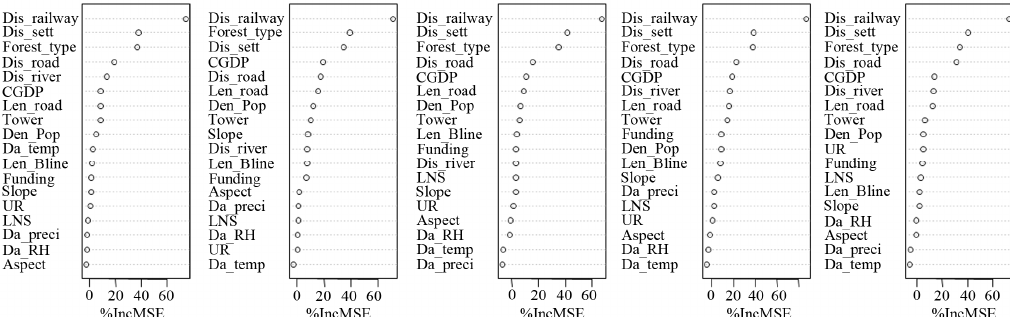
Figure 4. Variable importance measures from Random Forest sub ‐ samples based on Mean Decrease Accuracy ( X ‐ axis), which quantifies the importance of a variable by measuring the change in prediction accuracy when the values of the variable are randomly permuted compared with the original observations. The abbreviated variable names are the same as in Table 1.